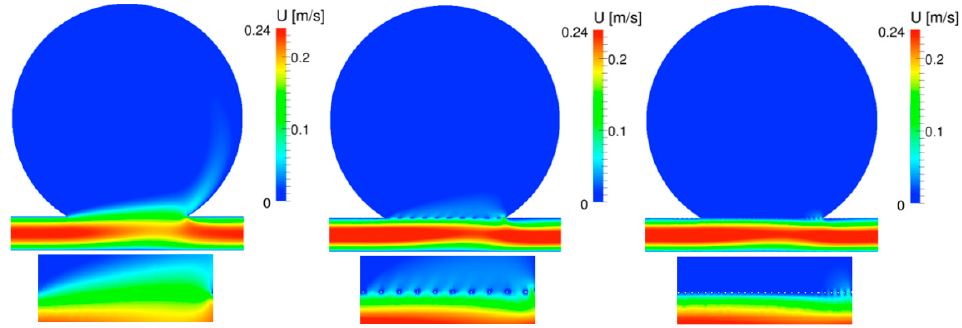
Figure 6. Velocity contour at the mid plane ( top ) and the zoom view of the velocity contour ( bottom ) of the UA ( left ), RS ( center ), and FD ( right ) at late diastole.